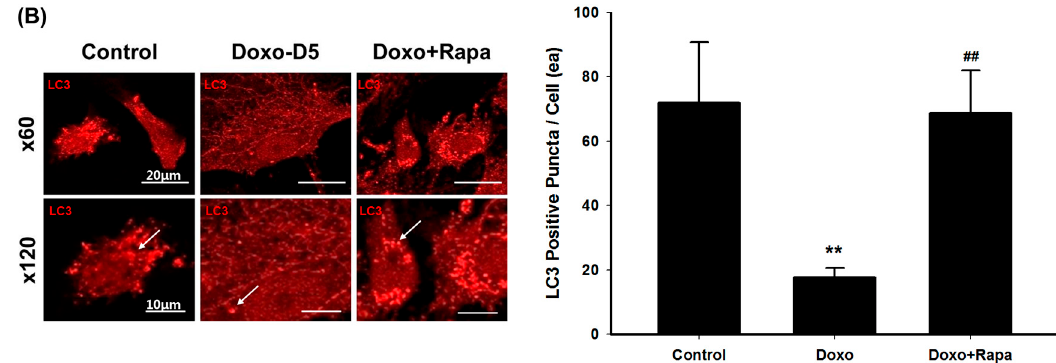
Figure 4. Rapamycin restores SMP30 and LC3 expression in DOXO-induced hCPCs. ( A ) hCPCs were incubated with doxorubicin (100 nM, 5 days) with or without stimulation by rapamycin (100 nM). The expression levels of mTOR, SMP30, and LC3 were assessed by Western blot. DOXO: doxorubicin, Rapa: rapamycin; DOXO + control: chronic treatment with doxorubicin hCPC (5 days); ( B ) Intracellular LC3 levels were measured using immunofluorescent assay and their fluorescence intensities were calculated by ImageJ software. Quantification of fluorescence intensities is presented in the right panel. ** p < 0.01 versus control, ## p < 0.01 versus doxorubicin. White arrows indicate LC3 autophagic puncta.